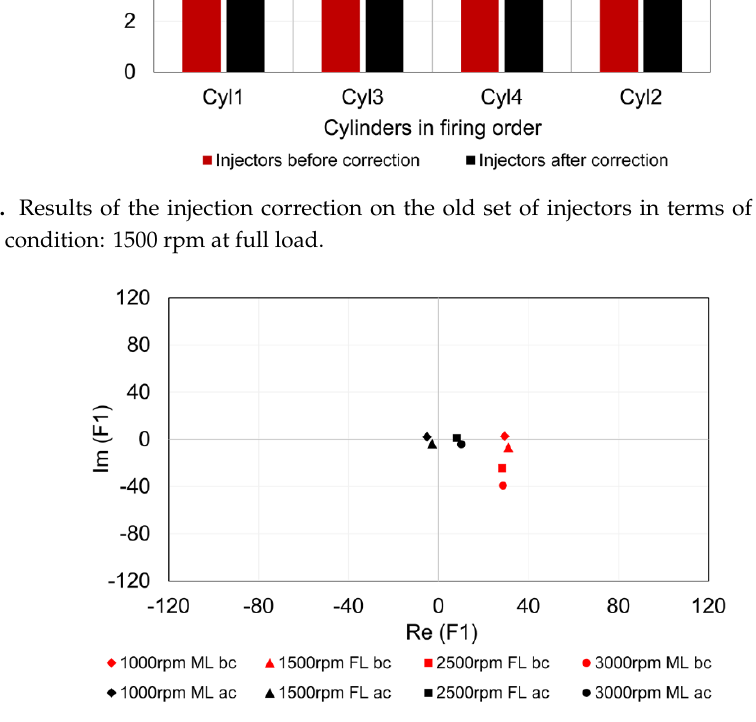
Figure 22. Results of the injection correction on the old set of injectors in terms of first order in the complex plane. Comparison between the old set of injectors before the correction (bc, red markers) and the old set of injectors after the correction (ac, black markers) at different engine operating conditions: 1000 rpm at medium load (ML), 1500 rpm at full load (FL), 2500 rpm at full load (FL), and 3000 rpm at medium load (ML).